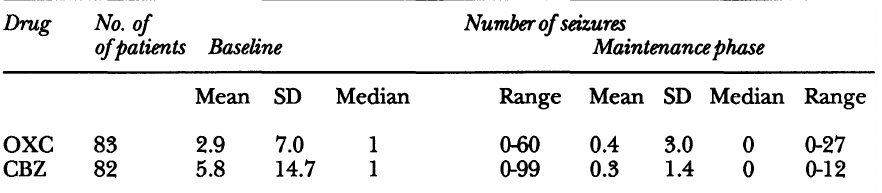
TABLE 2. Global evaluation of efficacy Drug No. of Efficacy (%) patients None Minimal Good Excellent axc 80